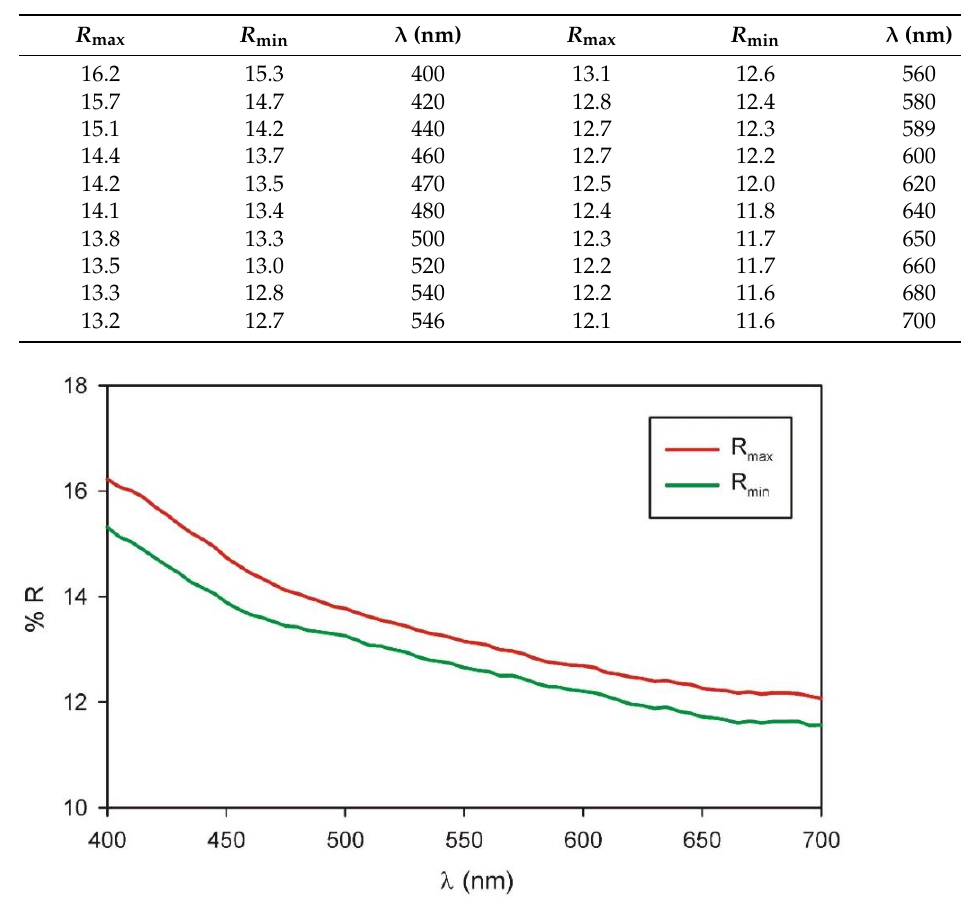
Figure 4. Reflectivity curves for amgaite.